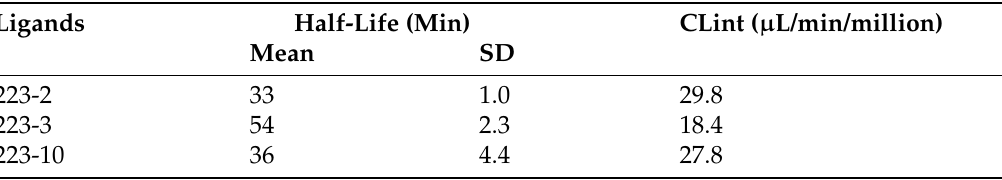
10 − 06 M (n = 3), SD = standard de- ×